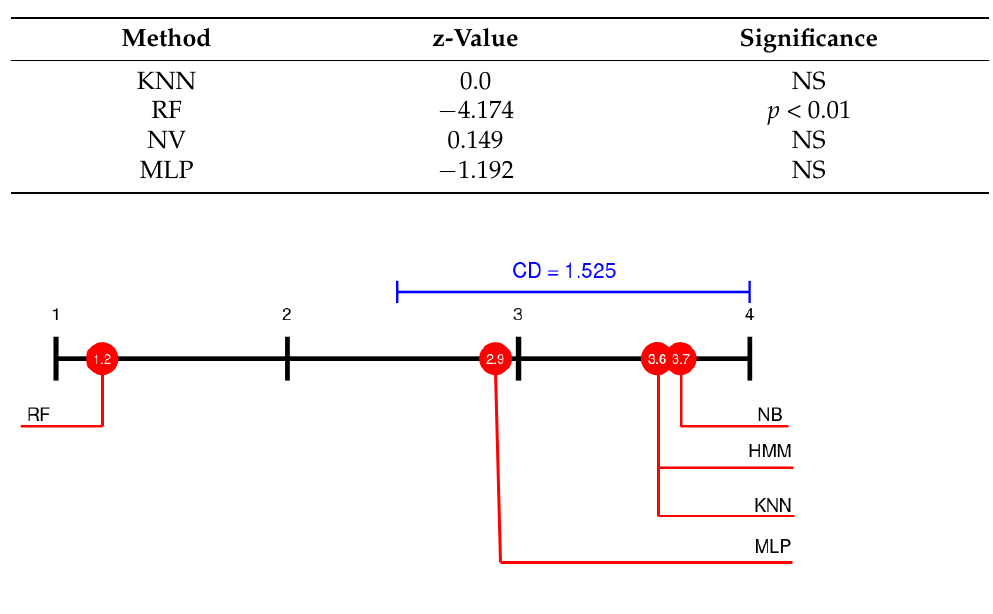
Table 7. Results of z-test for comparison of the proposed method (HMM) against the other methods. NS stands for not significant.